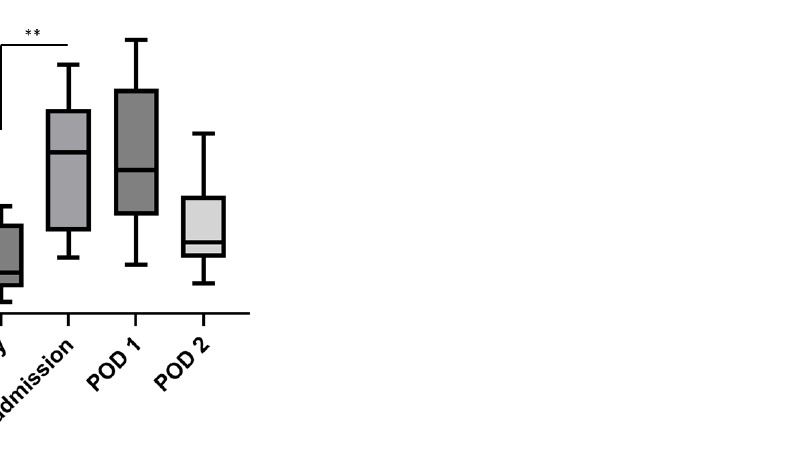
Figure 2. Concentration of syndecan-1 before and after surgery and on postoperative days (POD) 1 and 2. Box – Whisker Plot (Tukey method). ** = p ≤ 0.01.